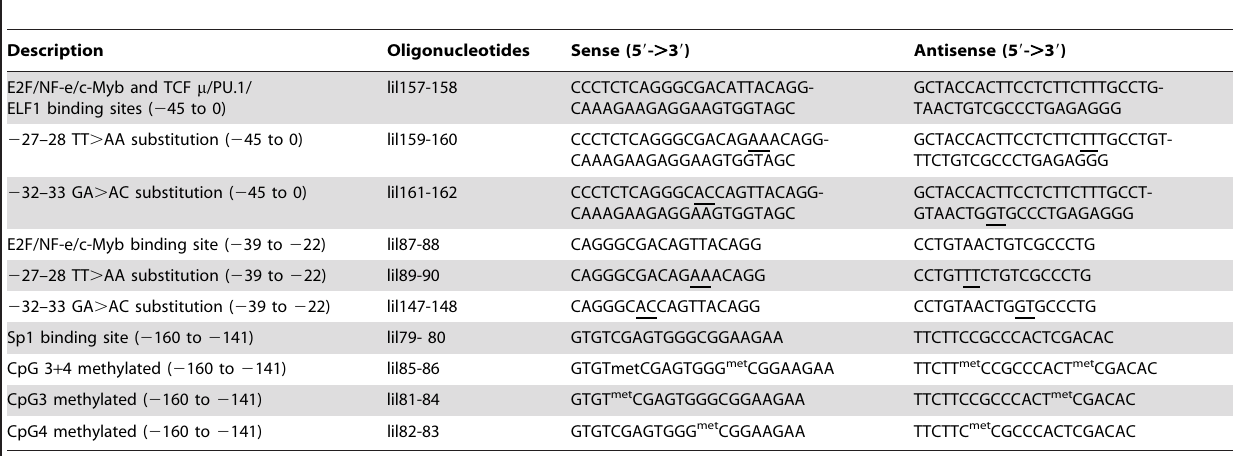
Table 3. Oligonucleotides used in EMSA, introduced mutations are underlined.